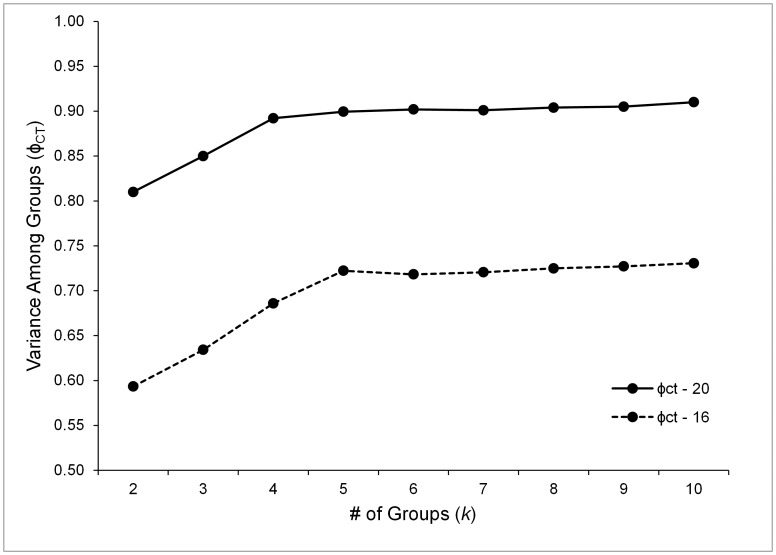
SAMOVA results illustrating variance in ND4 haplotype diversity attributable to S. thomense group structure (φ
CT).
φ
CT – 16 illustrates results for initial SAMOVA dataset, in which admixed populations are not split according to haplotype lineage: k = 5 groups explain almost all variation (North, West, Central+East, South, and Admixed). φ
CT – 20 illustrates results for second SAMOVA dataset, in which admixed populations are split according to haplotype lineage: k = 4 groups explain almost all variation (North, West, Central+East, and South).